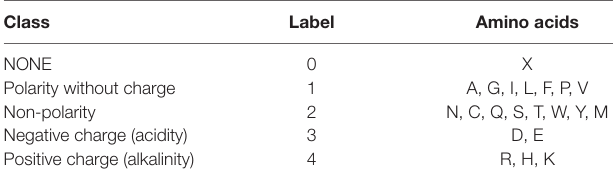
TaBLe 2 | Five Classes of amino acids based on polarity.